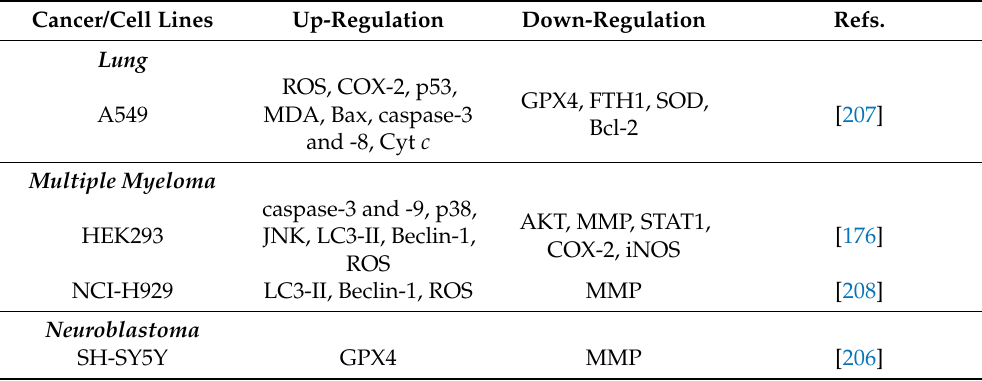
Table 4. Molecular targets of apigenin-induced ferroptosis. Cancer/Cell Lines Up-Regulation Down-Regulation Refs. Lung ROS, COX-2, p53, A549 MDA, Bax, caspase-3 and -8, Cyt c caspase-3 and -9,